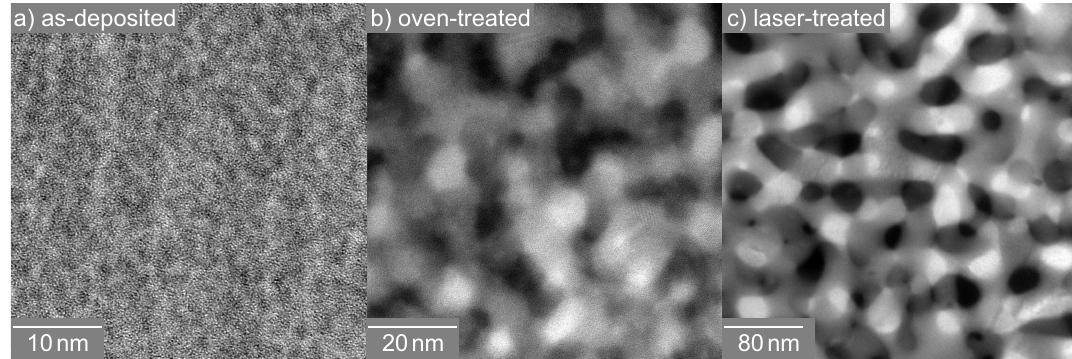
Figure 6. Cross-sectional Si plasmon-loss filtered TEM images (E loss = 17eV) of SiO 0.6 layers: as-deposited ( a ), after conventional oven ( b ) and after laser treatment ( c